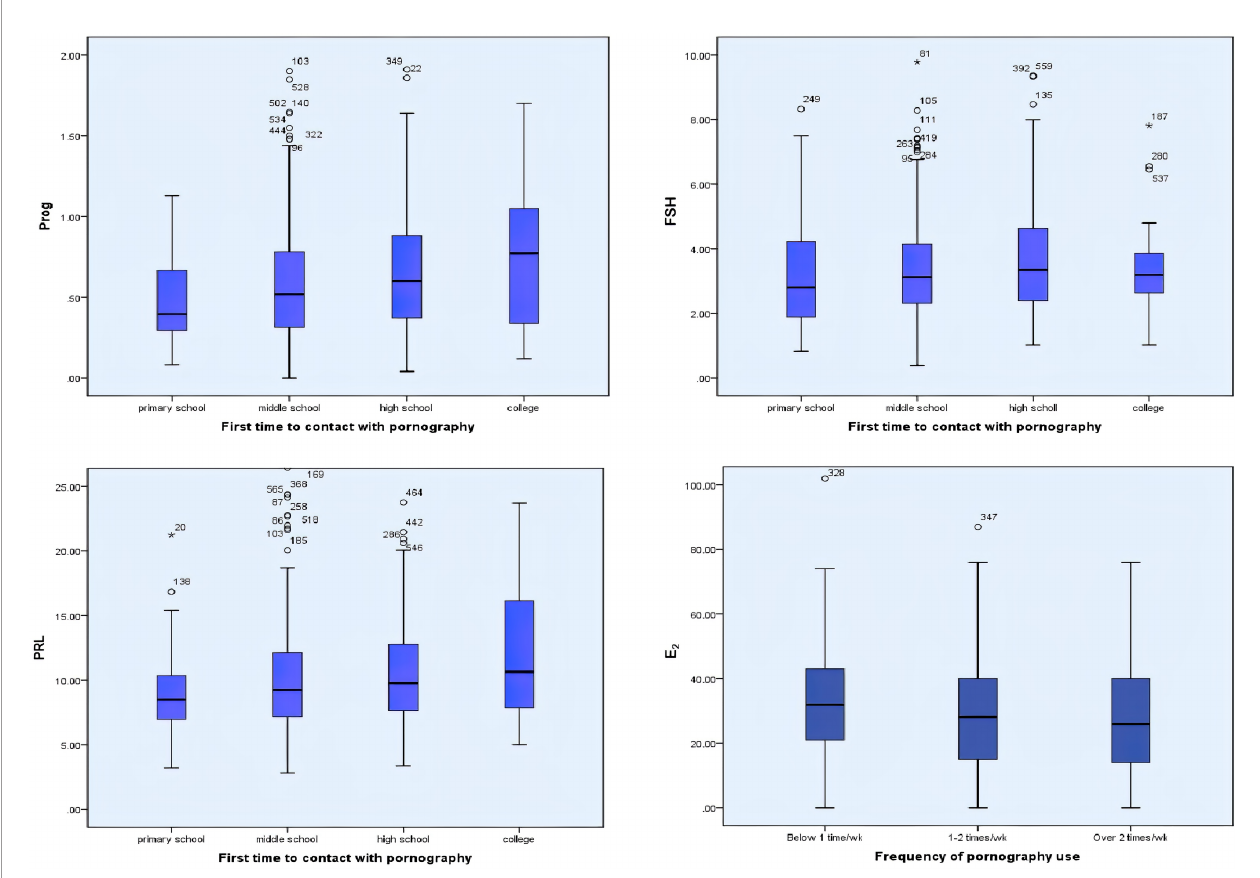
FIGURE 1 | Univariate analyses were applied to estimate the associations between pornography use and sex hormones. The ages of fi rst-time contact pornography were positively correlated with Prog, FS, and PRL concentrations in serum ( p < 0.05, p < 0.05, p < 0.05). The frequency of pornography use were negatively correlated with E 2 concentrations in serum ( p < 0.05). *:extreme values.